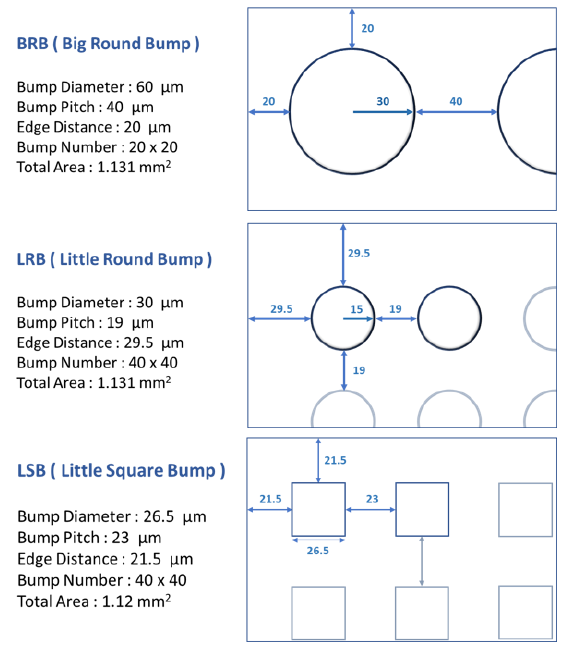
Figure 3. Specifications of the three bump types.